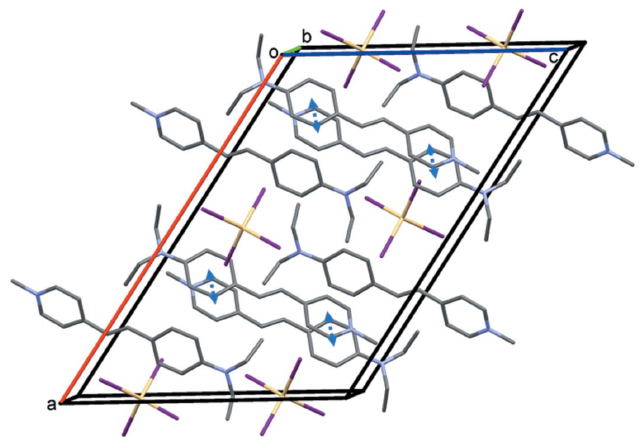
Figure 3 The crystal packing of salt (I), viewed along the b axis, showing the (cid:2) – (cid:2) interactions as double-headed blue arrows. For clarity, all of the H atoms have